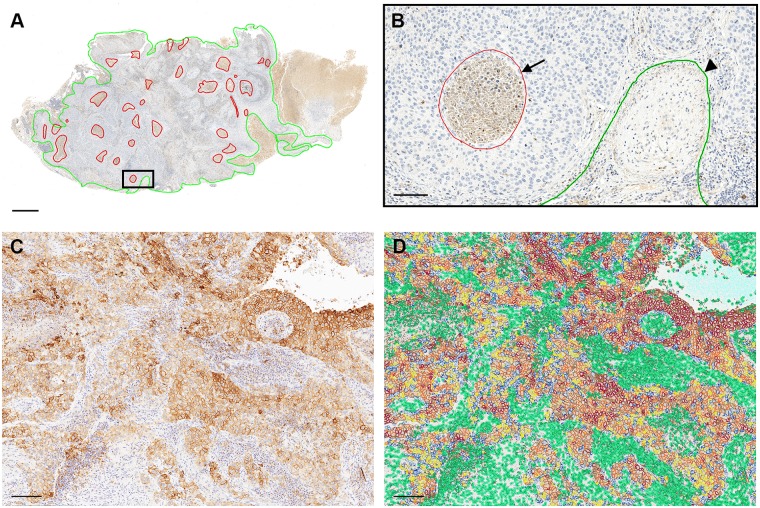
Example of computational tissue analysis (cTA) of NSCLC sections.A: Manual inclusion (green line) and exclusion (red line) annotations in squamous cell carcinoma tissue for CD56 IHC. B: Enlarged view area from (A) showing exclusion annotation around a central necrotic area in tumor-nest (arrow) and a segment of the inclusion annotation around the tumor mass margin (arrowhead). C: PD-L1 IHC of a squamous cell carcinoma. D: Algorithm markup from (C) showing membrane scoring only in cells assigned to the tumor-nest compartment, with 1+ = yellow, 2+ = orange, and 3+ = red. The separated TME compartment cell nuclei are marked in green. Scale bars: 1 mm (A); 100 μm (B); and 150 μm (C and D). NSCLC = non-small cell lung carcinoma; IHC = immunohistochemistry; TME = tumor microenvironment.